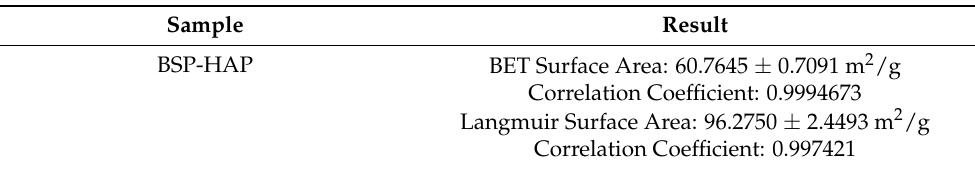
Table 2. Brunauer, Emmett, and Teller (BET) surface area of BSP-HAP. Where the BET surface area of BSP-HAP was 60.7645 m 2 /g.